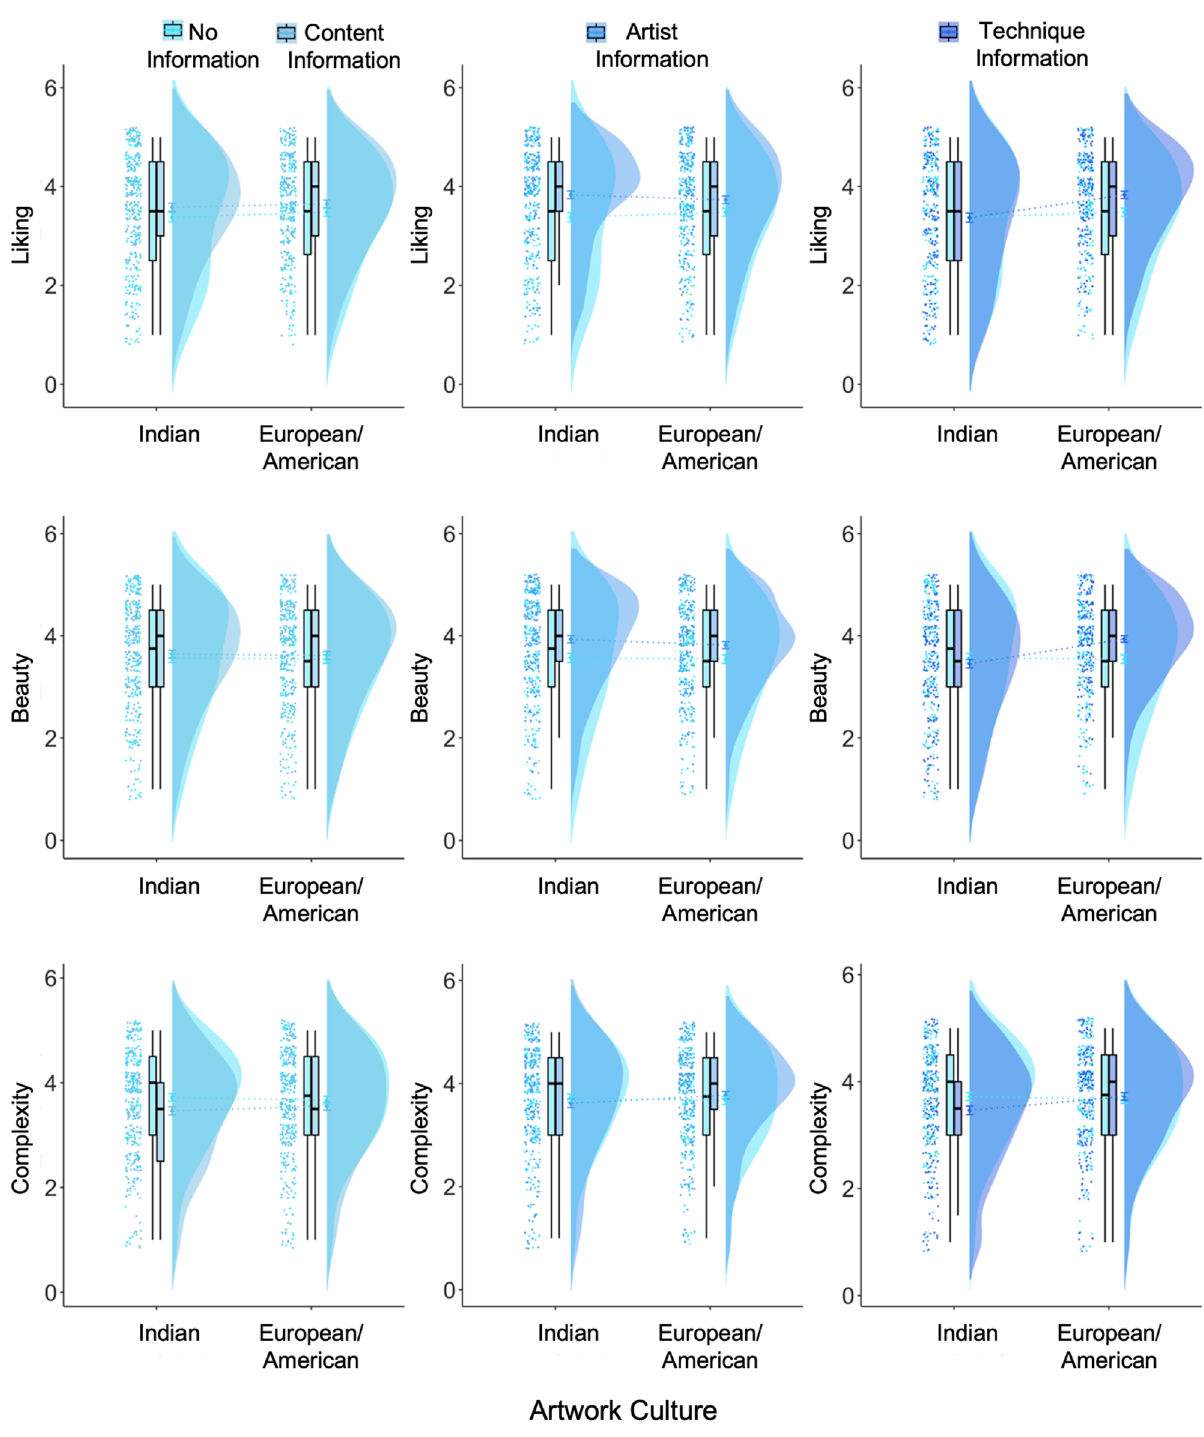
Figure 6. Liking, beauty, and complexity ratings for Indian and European/American artworks when no information is presented to participants compared to when content information (left), artist information (middle), and technique (right) information is presented to